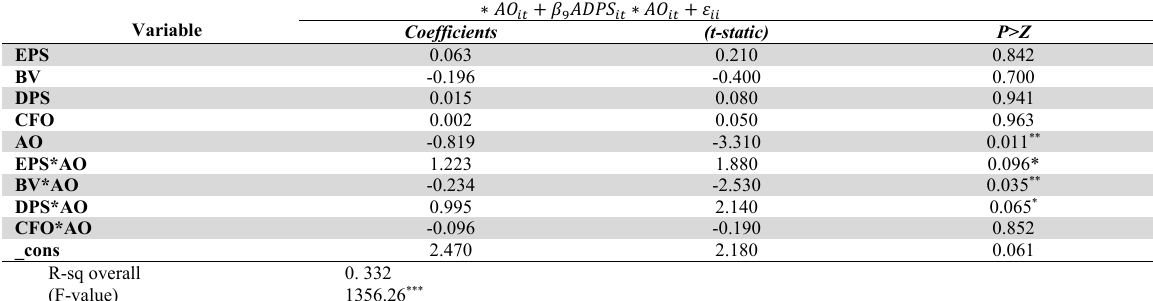
Results of Regression Analysis Related to Model